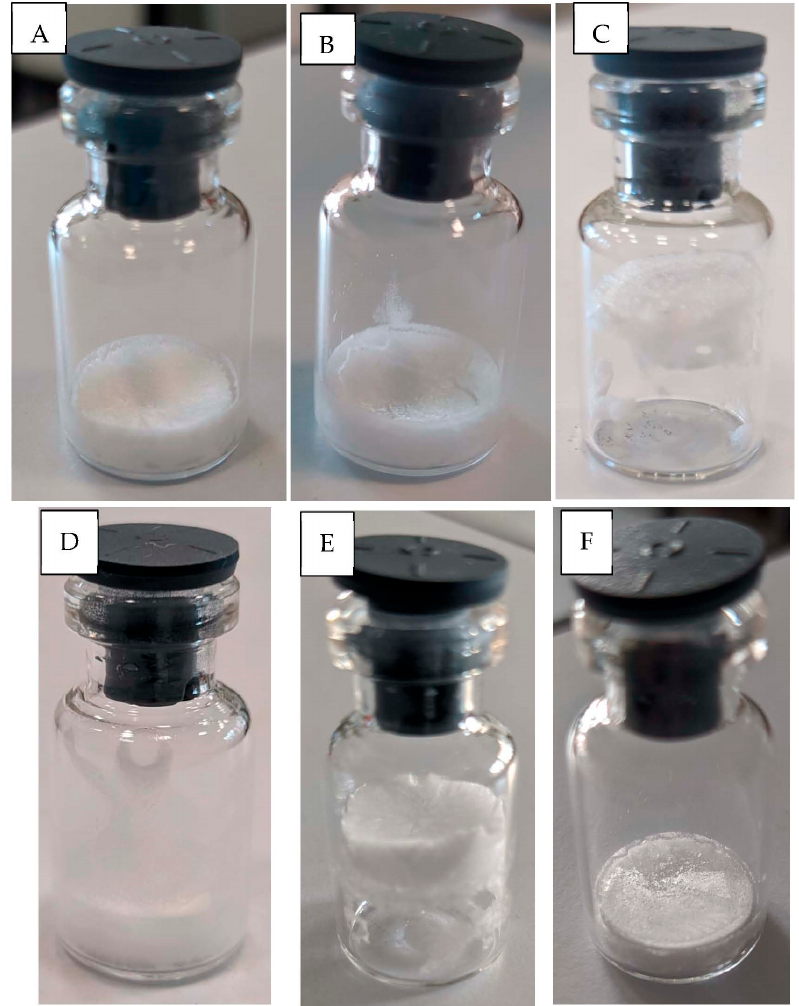
Figure 3. Most freeze-dried cakes of 5% w / w sucrose in untreated vials were aesthetically acceptable ( A ), but some of them showed fogging ( B ). When 5% w / w sucrose was dried in siliconized vials, prominent blow-up and boiling were observed ( C ). Freeze-dried cakes of 5% w / w sucrose + 0.02% w / v Tween 80 in untreated ( D ) or siliconized ( E ) vials displayed aesthetic defects, mostly due to fogging and bubbling/blow-up, respectively. Freeze-dried cakes obtained for 5% w / w sucrose + 0.02% w / v Tween 80 in siliconized vials after degassing ( F ) showed instead a good appearance. All these pictures were taken after secondary drying.